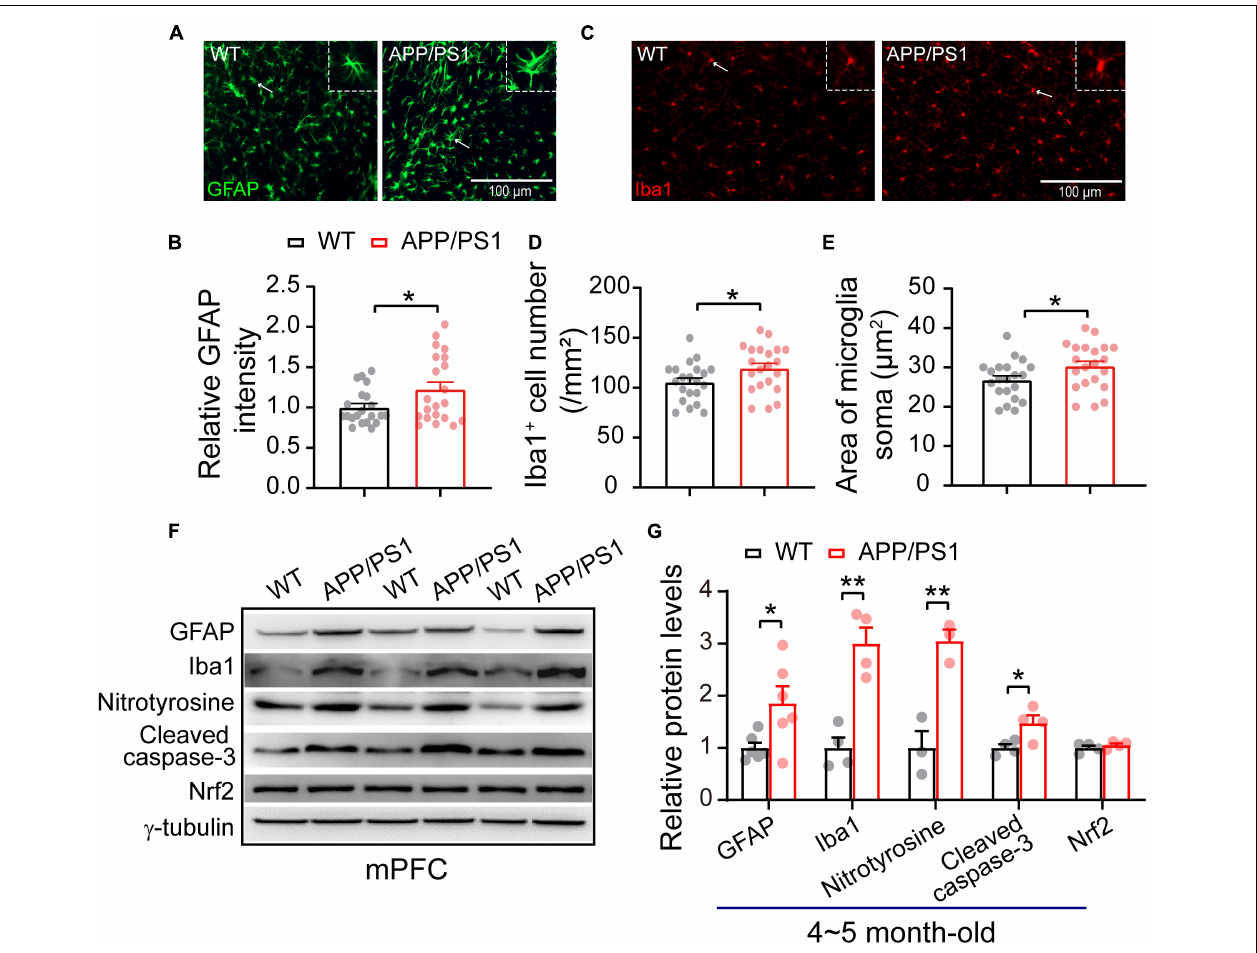
FIGURE 6 | Increased neuroinflammation and oxidative stress in the mPFC of 4 ∼ 5 month-old APP/PS1 mice. (A) Immunofluorescent staining of GFAP in mPFC sections. (B) Higher levels of GFAP in the mPFC of APP/PS1 mice than in WT mice (7 slices/per mouse, 3 mice per genotype). (C) Immunofluorescent staining of Iba1 in mPFC sections. (D,E) Increased Iba1 + cell number and soma size, showing microglial activation, in the mPFC of APP/PS1 mice compared to WT mice (7 slices/per mouse, 3 mice per genotype). (F,G) Western blotting showing significantly increased levels of GFAP, Iba1, nitrotyrosine, and cleaved caspase-3 but unchanged Nrf2 in the mPFC of APP/PS1 mice compared to WT mice; n = 3–6 mice per genotype; two-sample t -test. Values represent the mean ± SEM, * p < 0.05, ** p <